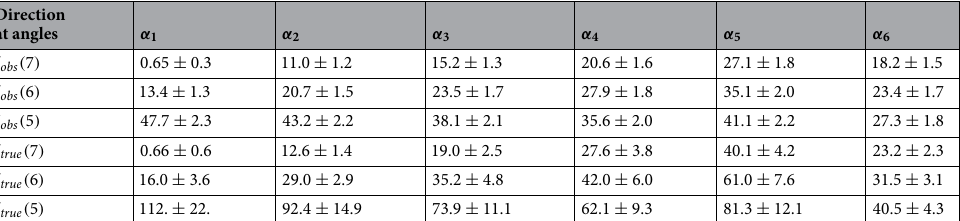
Table 2. Experimental luminance of fringes in the vicinity of the first main minima: the observation ( from Column (II), Fig. 2) and the dead-time corrected quantities (by correction factor τ d = 0.012 ). Uncertainties of I obs ( j ) are statistical errors, while uncertainties of the corrected luminance I true ( j ) consist of statistical and three kinds of systematical errors by �τ d , Multi-photon interference and slit microstructure